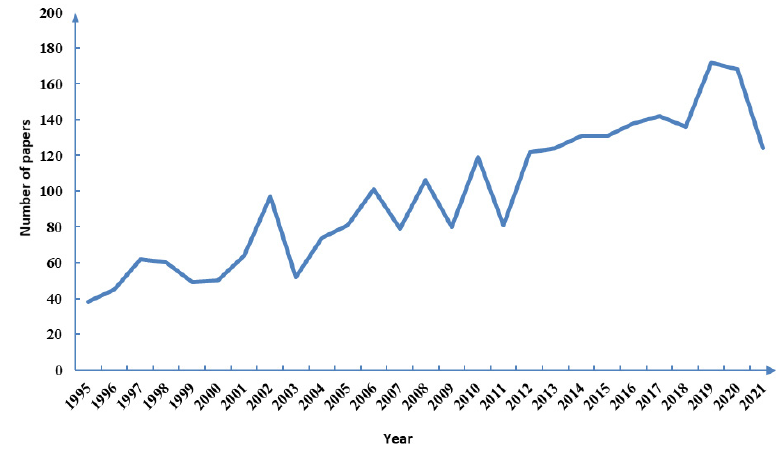
Figure 1. Annual trend chart of publications.